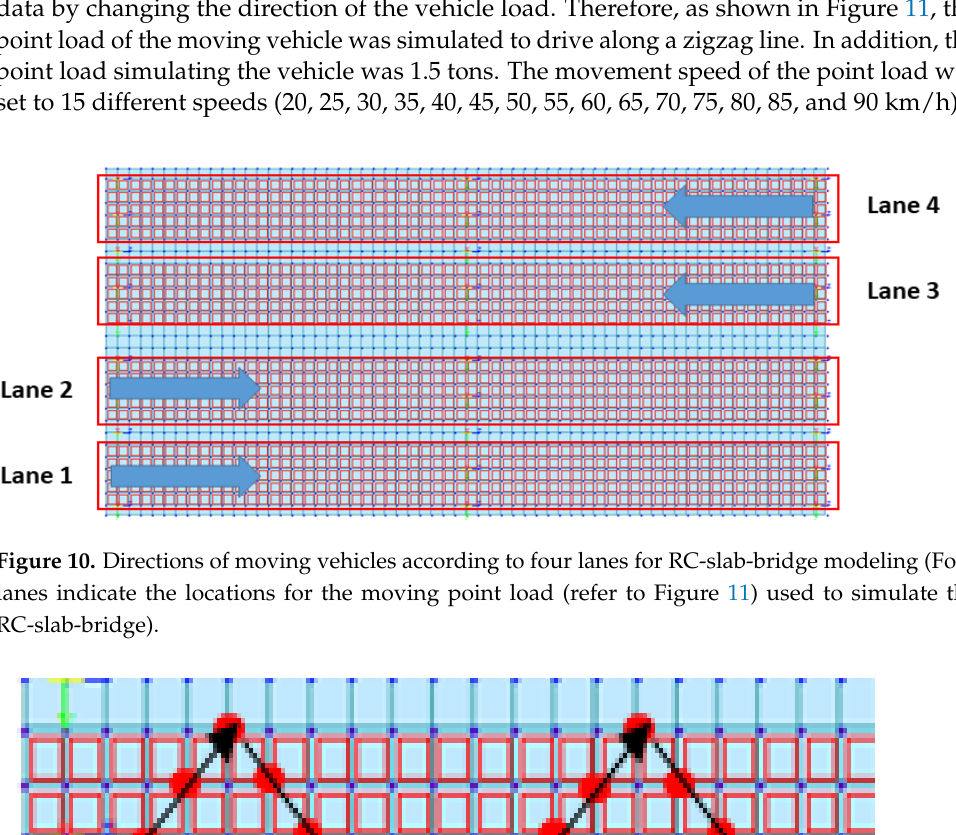
Figure 9. RC-slab-bridge modeling.